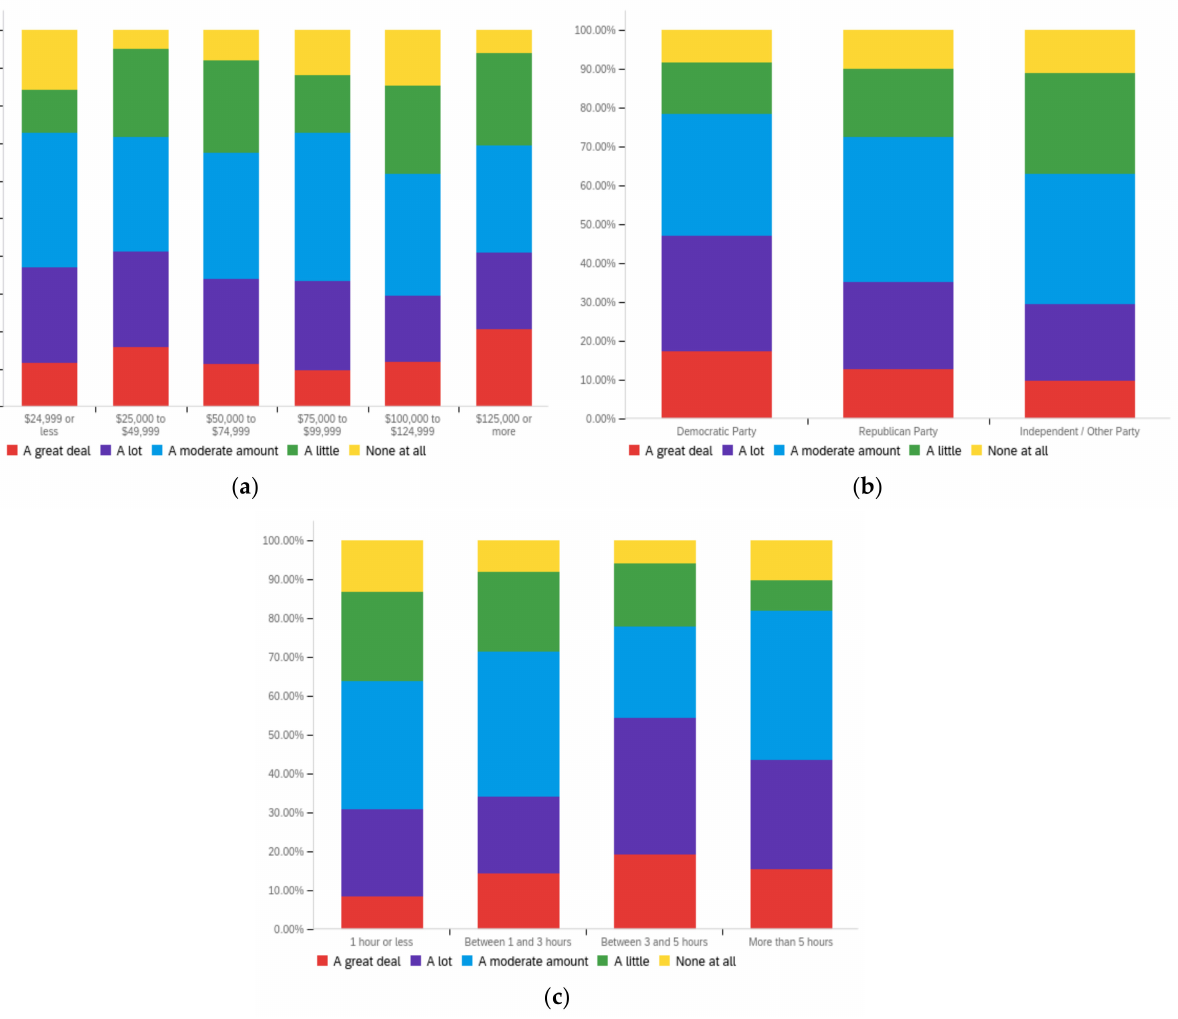
Figure A8. Article publication date—others’ perception impact by: ( a ) income level (top left), ( b ) po- litical affiliation (top right) and ( c ) online usage